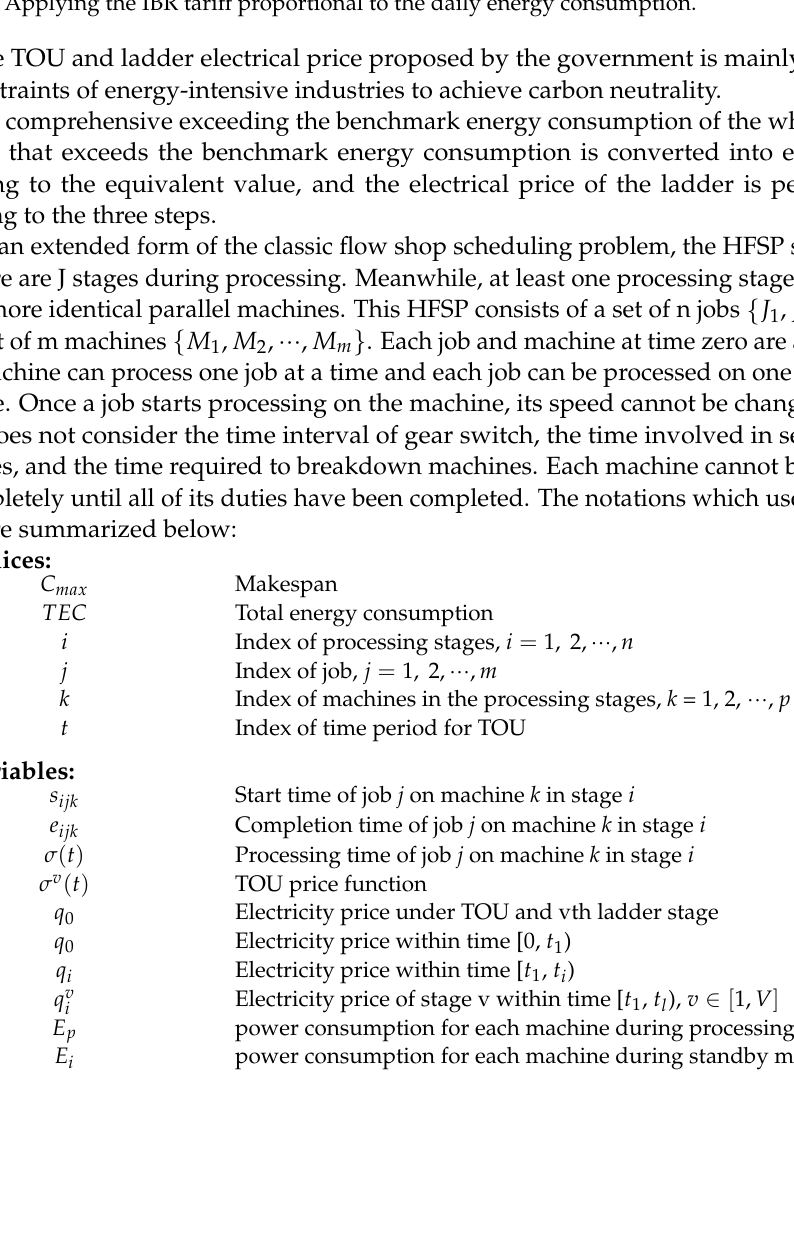
Figure 2. Applying the IBR tariff proportional to the daily energy consumption.